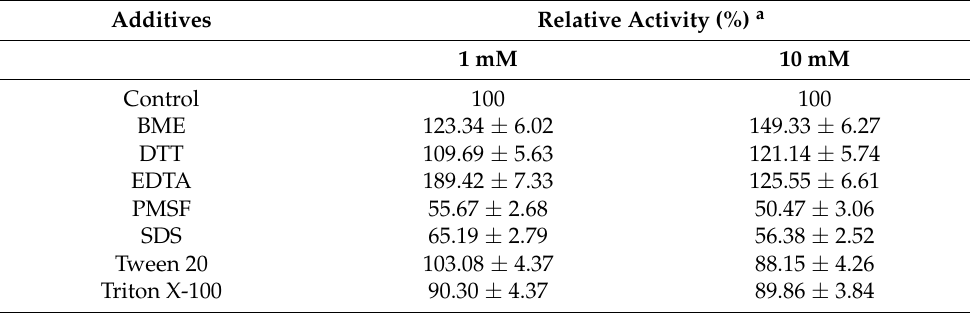
Table 4. Effect of different additives on Beauveria bassiana SAN01 xylanase